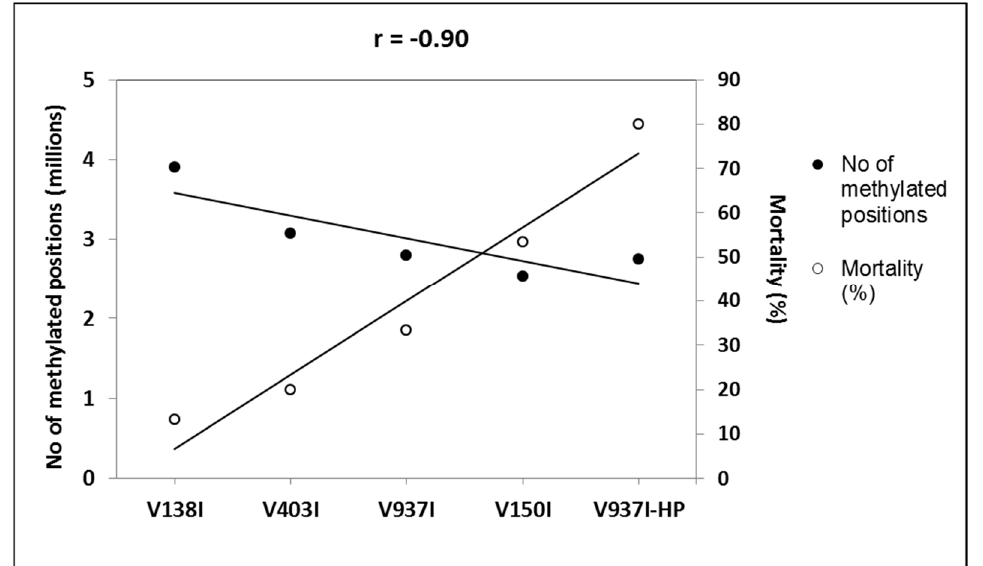
Figure 4. Negative correlation between virulence and DNA methylation of the protein-coding genes. The number of the total methylation positions in the protein-coding genes and the mortality induced data are represented. The isolates are placed from left to right, and they are ordered by increasing